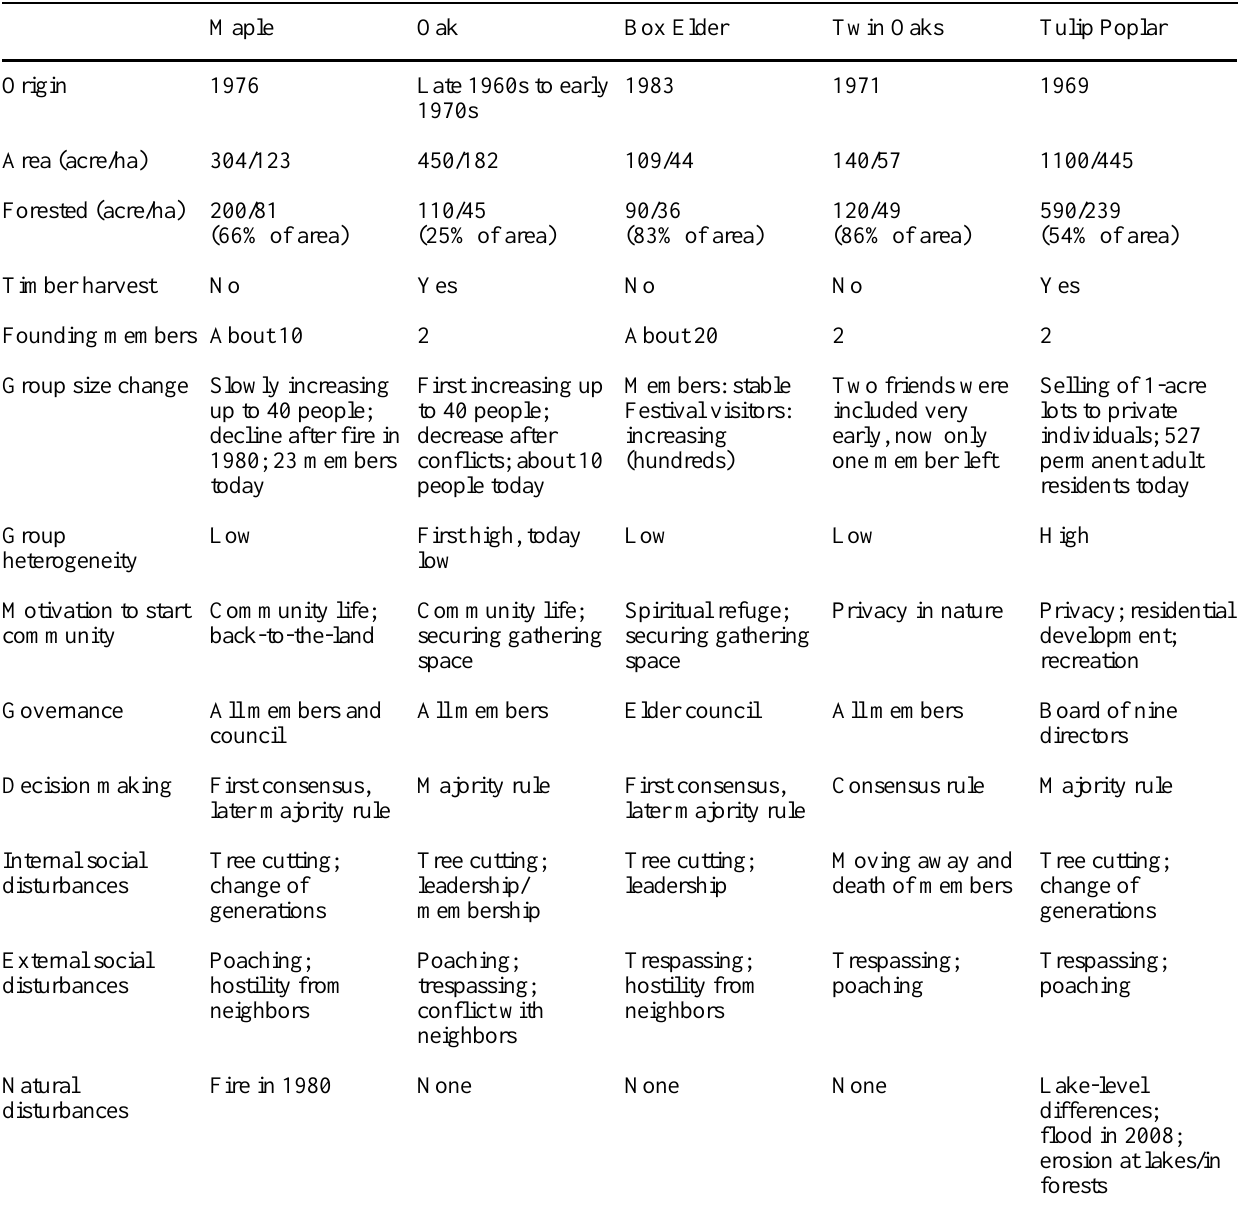
Table 2 . Characteristics of five forest communities in southern